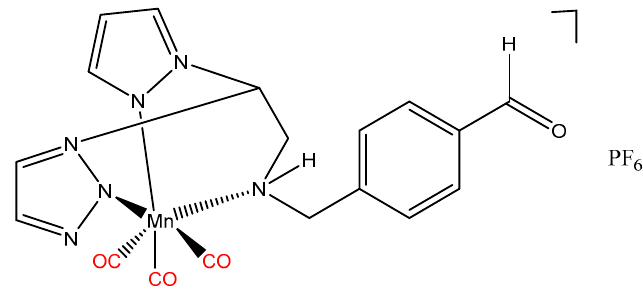
Figure 11. The synthesis route of [Mn(bpea NHCH2C6H4CHO )(CO) 3 ]PF 6 for Photo ‐ CORMats.